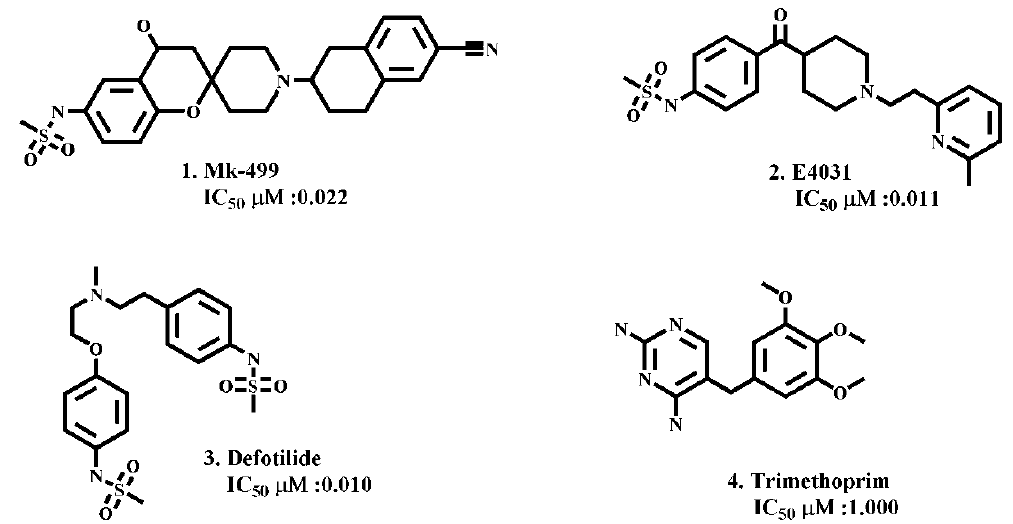
Figure 4. Showing prototype hERG inhibitors (1) Mk-499, (2) E4031, (3) Defotilide, (4) Trimethoprim with best activity lipophilic and ligand efficiency ratios .